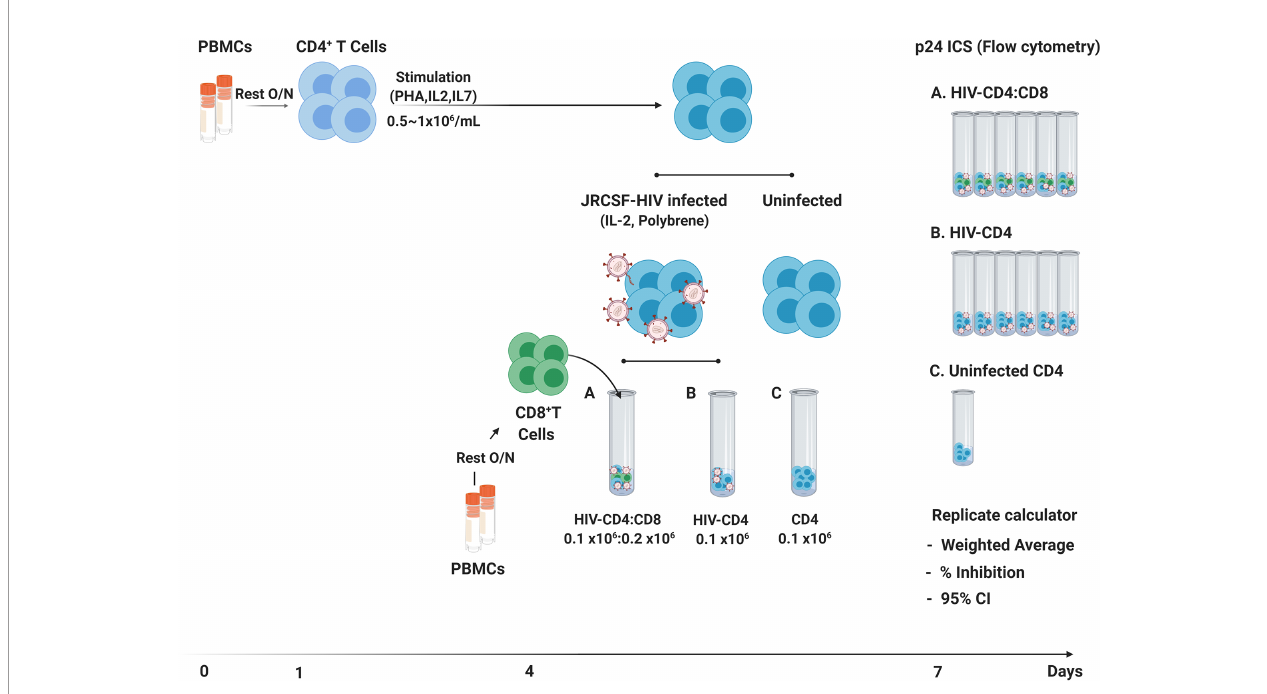
FIGURE 1 | Schematic of 7-day VIA. Following an overnight rest (Day 0), CD4 T cells isolated by negative bead selection (Day 1) are activated in bulk culture for 3 days. On day 4, CD4 T cells are infected with HIV-JRCSF by spin-oculation with addition of Polybrene ™ and thawed CD8 T cells are isolated by positive bead selection from autologous PBMCs. Independent cultures of CD4 T cells not JRCSF infected (n = 1), JRCSF infected CD4 T cells (n = 6) and JRCSF-CD4 T cells + CD8 T cells in 1:2 (n = 6) are set up in round-bottom fl ow-cytometry tubes and then cultured for another 3 days. On Day 7, all cultures (13 per participant) are stained and acquired by fl ow cytometry to measure intracellular p24+ frequency in CD4 (CD3 + CD8 - ) T cells. Flow data are exported to the VIA replicate calculator ( Supplementary Material 4 ) for automated calculation of weighted averages across replicate cultures, % virus inhibition and 95% con fi dence